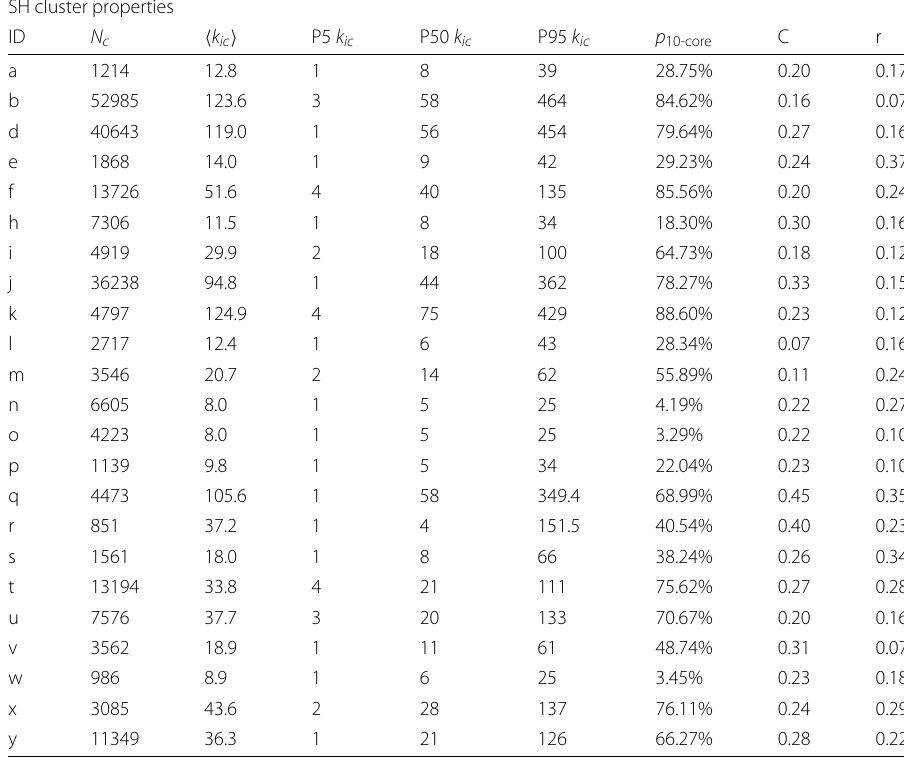
SH cluster properties